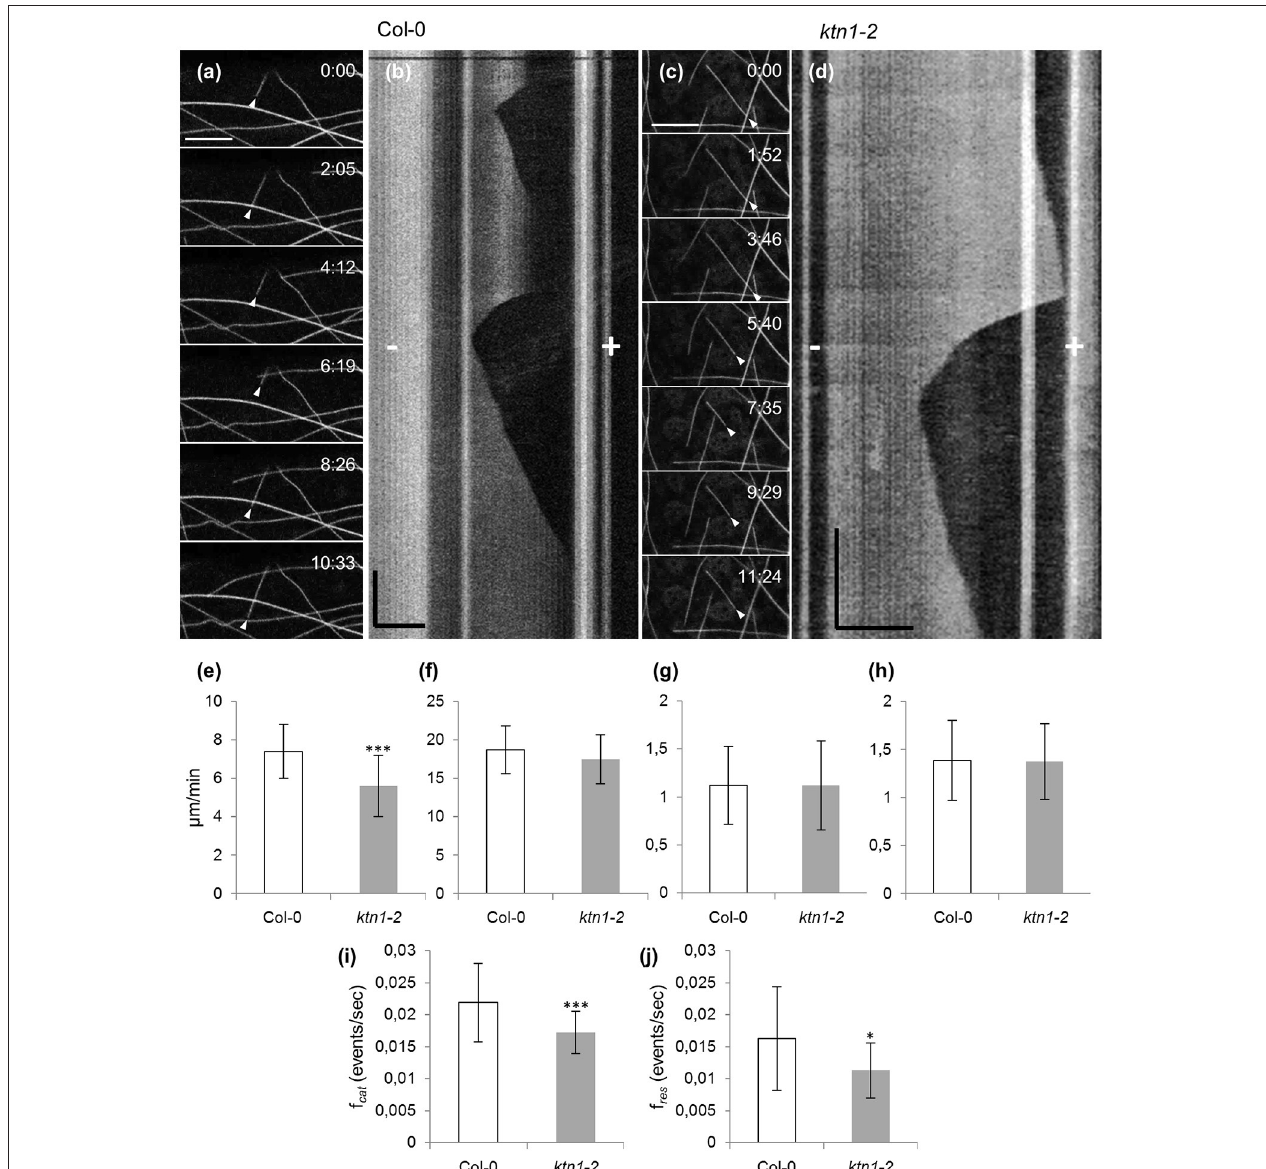
FIGURE 3 | Time lapsed 2D imaging of cotyledon epidermal cell cortical microtubules by CLSM and quantitative analysis of end-wise dynamics in Col-0 and ktn1-2 mutant, stably expressing a GFP-TUA6 microtubule marker. (a,b) A single microtubule from Col-0 exhibiting dynamic instability from the plus end ( a , arrowhead) and the respective kymograph (b) with annotations of plus ( + ) and minus ( − ) ends. (c,d) An individual microtubule ( c , arrowhead) from ktn1-2 showing dynamic instability and the respective kymograph (d) with annotations of plus ( + ) and minus ( − ) ends. (e–h) Quantification of average values ( ± S.D) of plus end growth ( e , n = 40 and 36 for Col-0 and ktn1-2, respectively; *** p < 0.001), shrinkage ( f , n = 39 and 40 for Col-0 and ktn1-2, respectively), and minus end growth ( g , n = 18 and 14 for Col-0 and ktn1-2, respectively) and shrinkage ( h , n = 26 and 25 for Col-0 and ktn1-2, respectively). (i,j) Catastrophe ( i , *** p < 0.001) and rescue ( j , * p < 0.05) frequencies (mean ± S.D) comparing Col-0 and ktn1-2 ( n = 39 microtubules for Col-0 and n = 40 microtubules for ktn1-2 ). These and other microtubule dynamics parameters can be found in Table 1 . Scale bars: 10 µ m (a–c) 5 µ m (d) ; Time bars: 1 min (b) , 2min (d) . Numbers in (a,c) correspond to time (min:s).